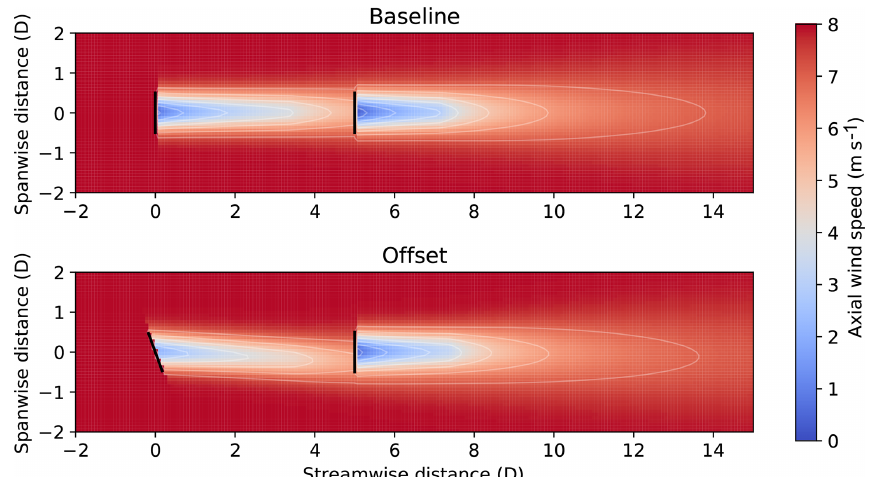
Figure 1. Examples of wakes for a two-turbine scenario with five rotor diameter ( D ) spacing using FLORIS. In the baseline case, both turbines are aligned with the wind direction. For the offset case, the upstream turbine has a yaw offset of 20 ◦ .